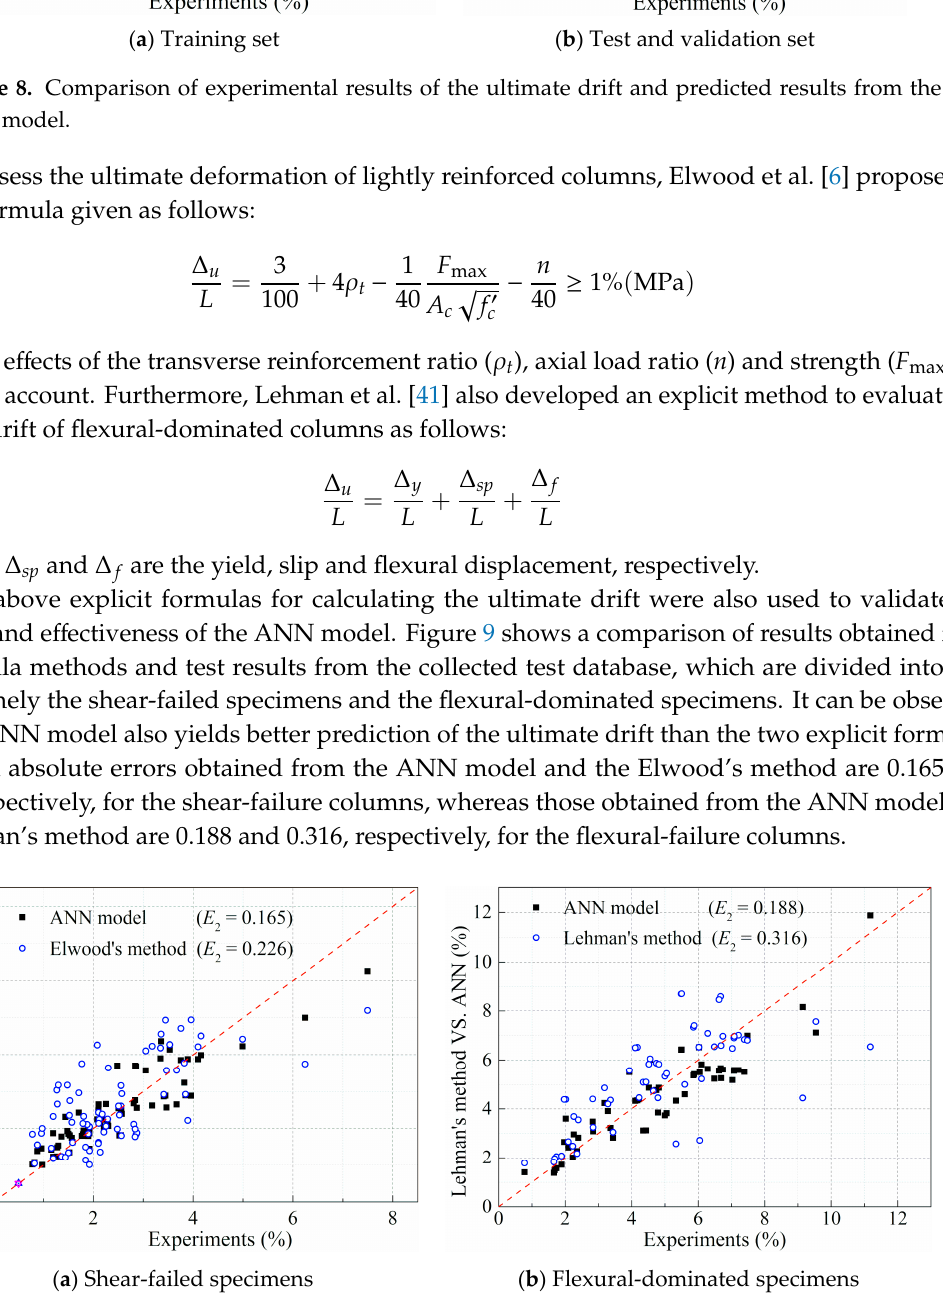
Figure 9. Comparison results of the ultimate drift between the experimental, ANN model and explicit methods.